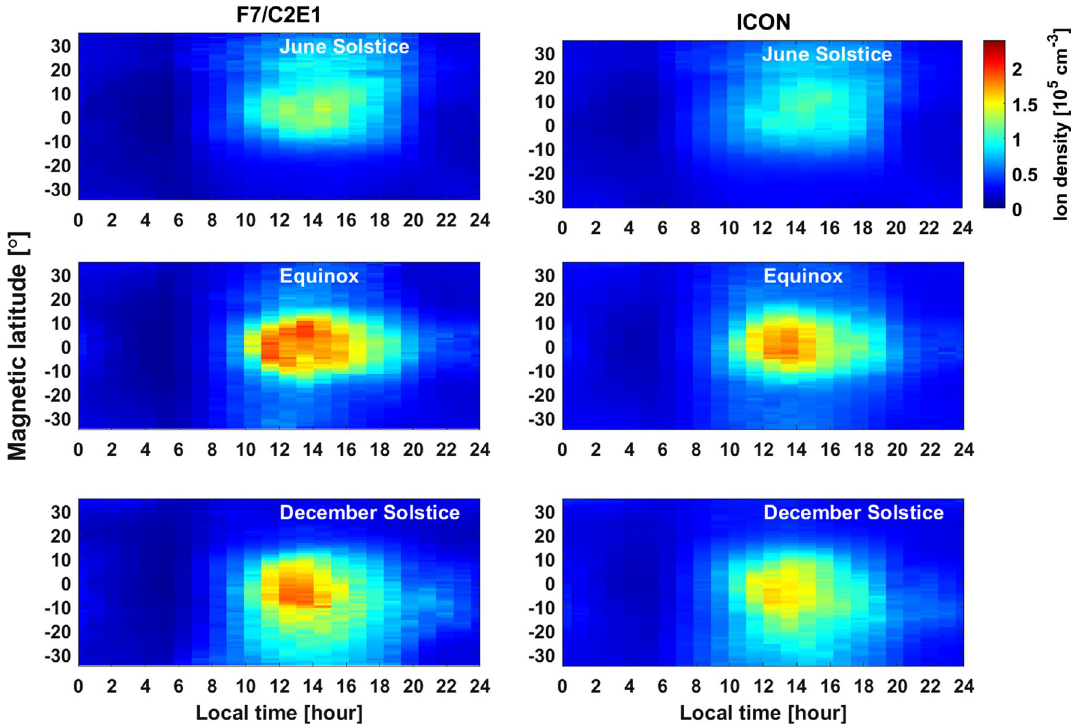
Fig. 5 The magnetic latitude and local time distributions of the topside average ion densities observed by F7/C2E1 and